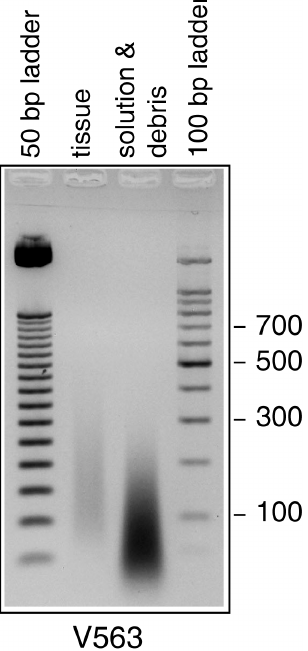
Figure 3. Agarose gel electrophoresis of ethidium bromide-stained DNA extracted from specimen V563.